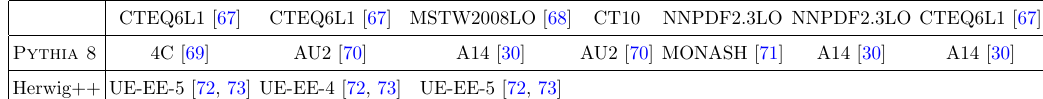
Table 1 . Summary of the soft-physics model tunes used for the evaluation of the non-perturbative corrections for each event generator and PDF